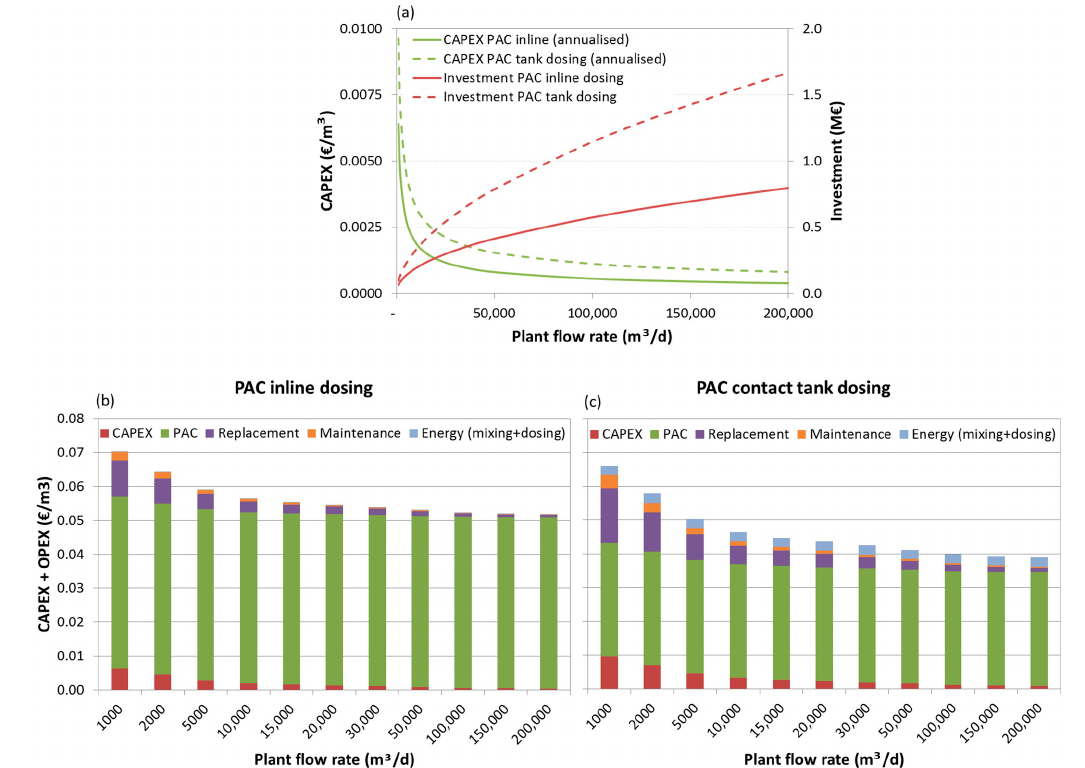
Figure 8. Investment costs and annualised CAPEX ( a ) and total (CAPEX+OPEX) production costs breakdown for scenario 3, dosing 18 mg/L PAC inline ( b ) and 12 mg/L PAC to tank ( c ).